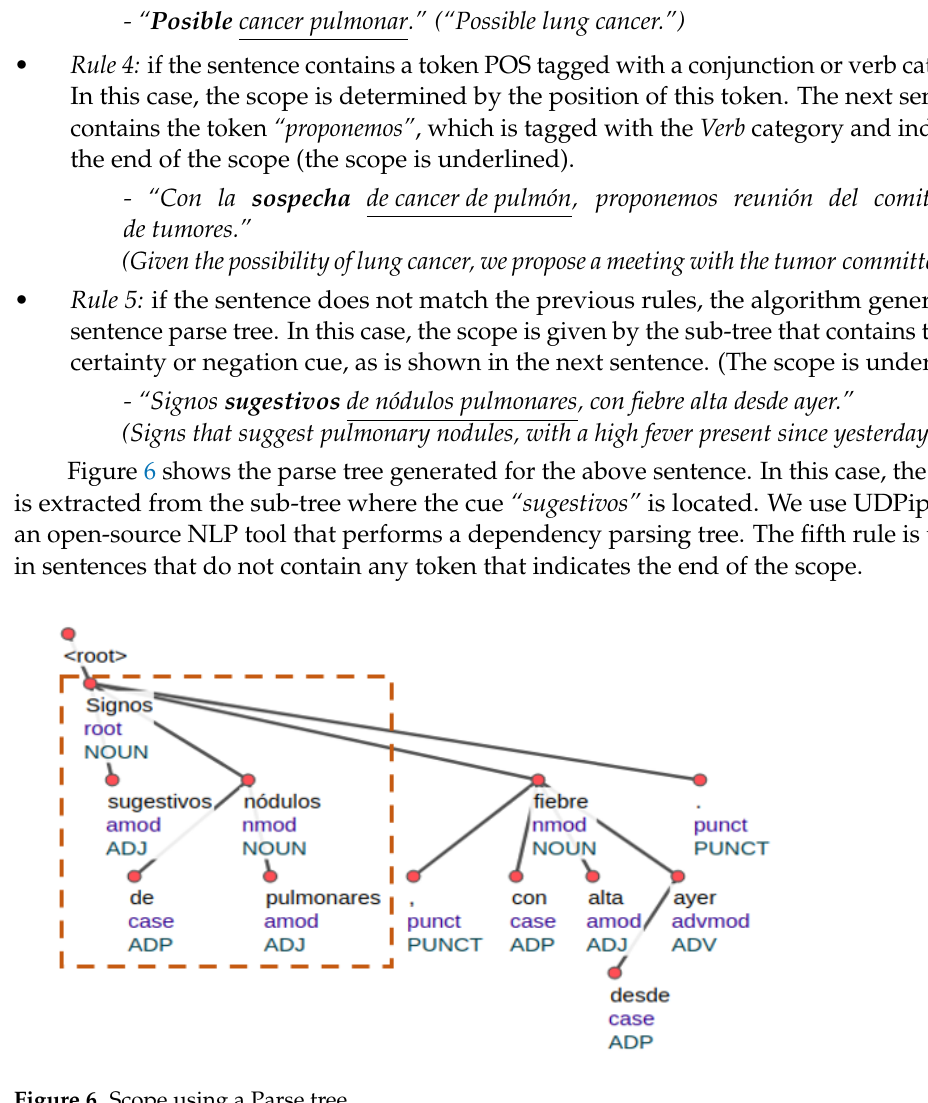
Figure 6. Scope using a Parse